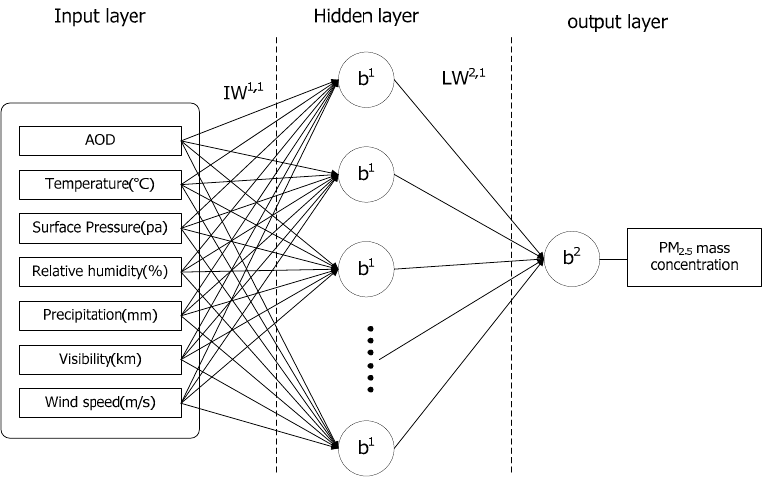
Figure 3. Topological structure of the back propagation neural-network (BPNN) model. IW is the weight matrix of the input layer to the hidden layer; LW is the weight matrix between the hidden layer and the output layer; b is the threshold vector. 1 means the first hidden layer; 2 is the output layer.